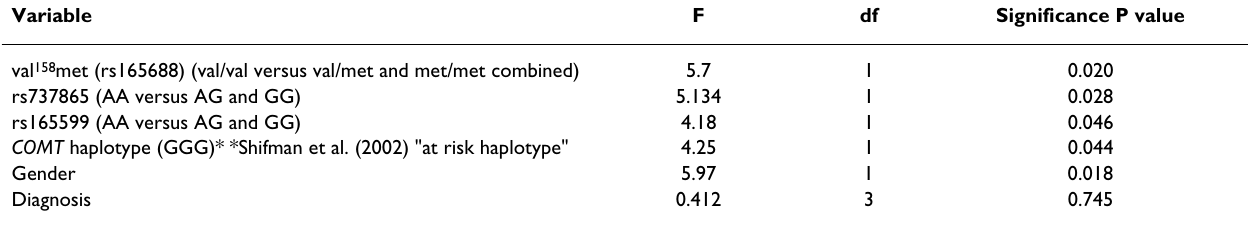
Table 2: ANCOVA analysis of COMT gene expression Variable F df Significance P